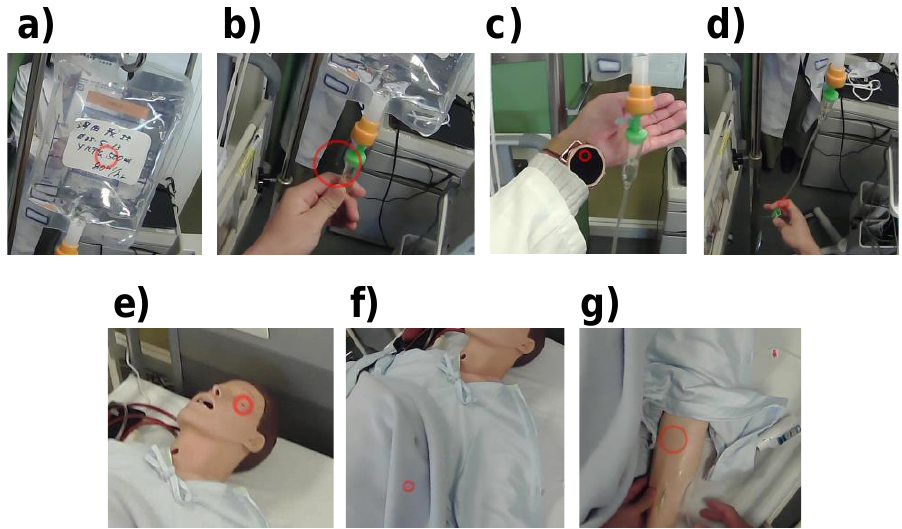
Figure 3. AOIs in this study: ( a ) bag, ( b ) chamber, ( c ) watch, ( d ) cock, ( e ) face, ( f ) sheets, and ( g ) inner elbow.